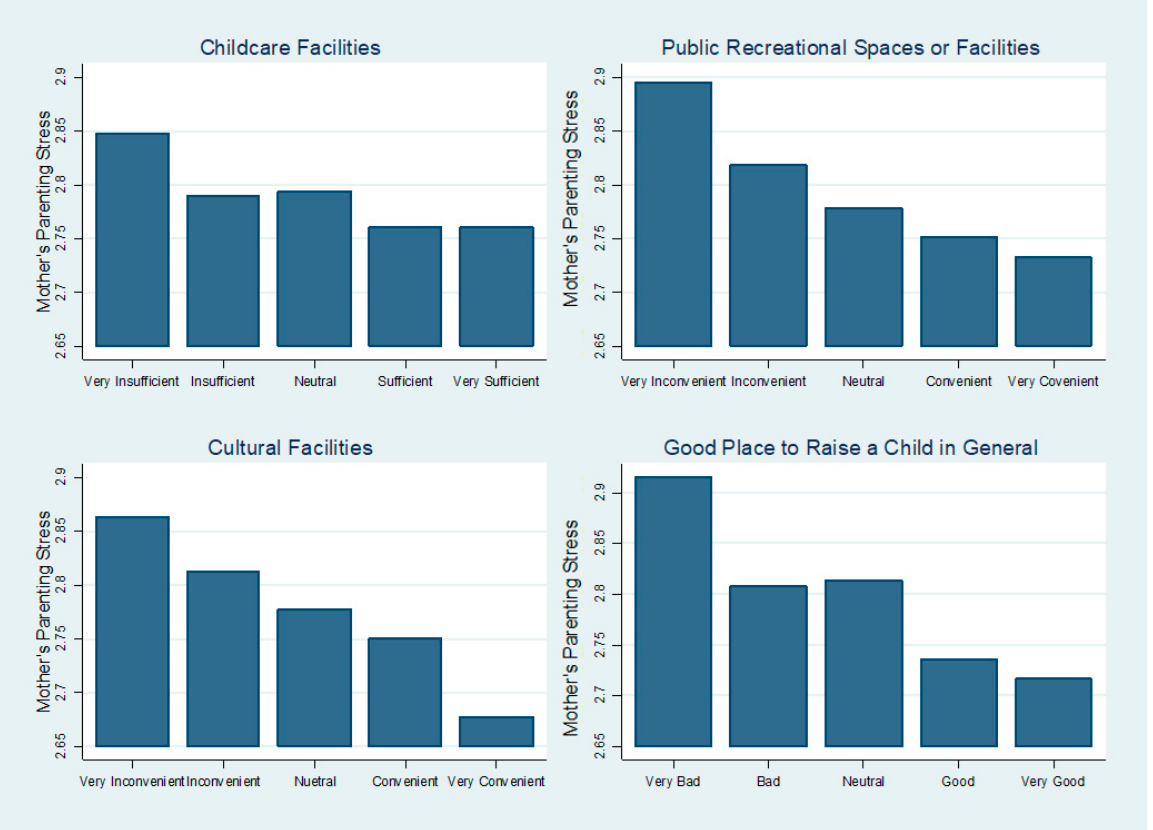
Figure 3. Predicted Mother’s Parenting Stress by Neighborhood Characteristics. Further, to understand whether the effect of neighborhood characteristics on mothers’ parenting stress varies by children’s age, we included and examined the interaction terms between neighborhood characteristics and child’s age in the models (Appendix A). To increase the statistical power and ease of interpretation, in the interaction models, we merged “very insufficient” and “insufficient,” and “very sufficient” and “sufficient.”